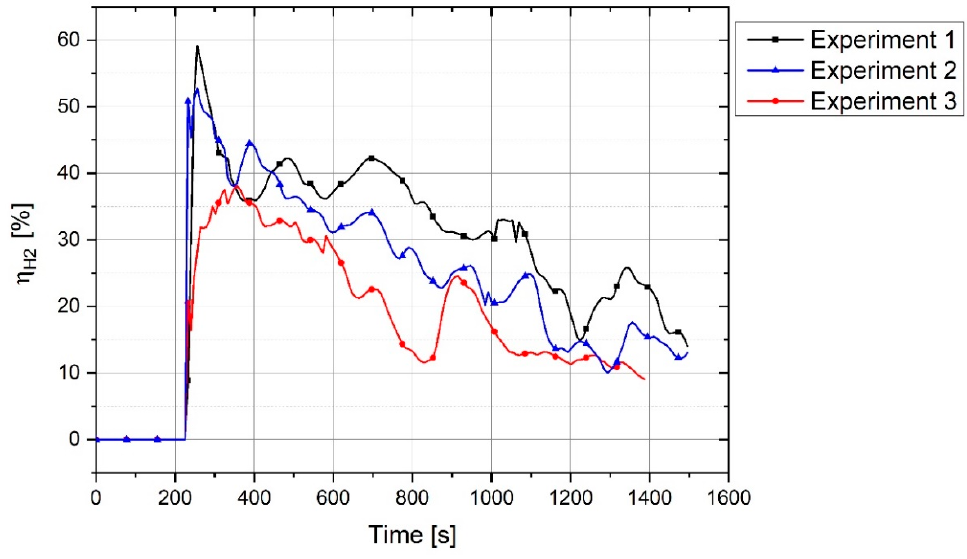
of Experiments 1, 2 and 3. Figure 14. η H 2 (cid:3118)